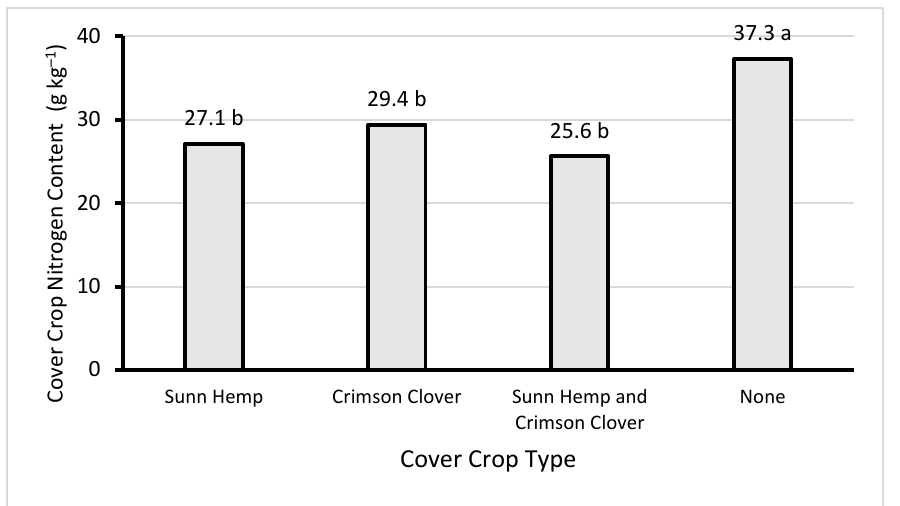
Figure 2. Cover crop biomass nitrogen content (g kg − 1 ) as a function of cover crop treatment. Means followed by the same letter are not significantly different from each other according to Bonferroni adjusted t-tests at p ≤ 0.05.